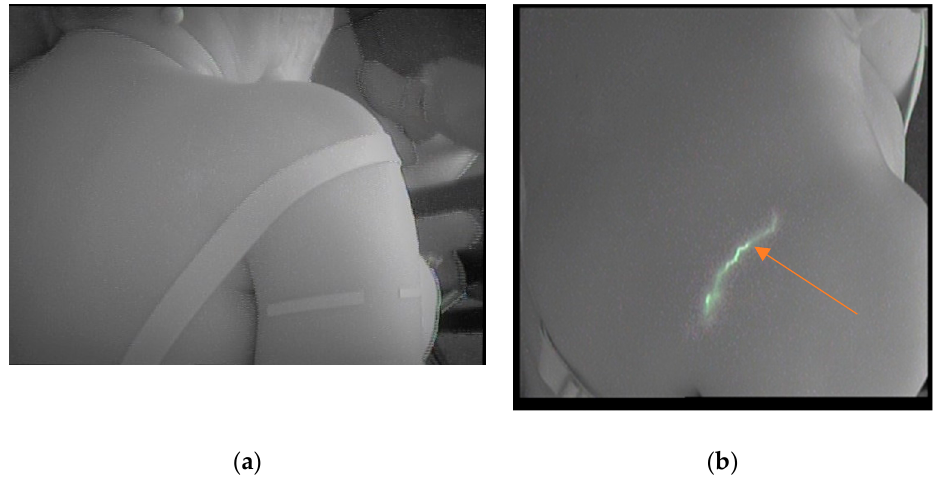
Figure 4. ( a ): Visualization of the scapular area pretest; ( b ) Pathway from the affected scapula to ipsilateral supraespinal region (postest).